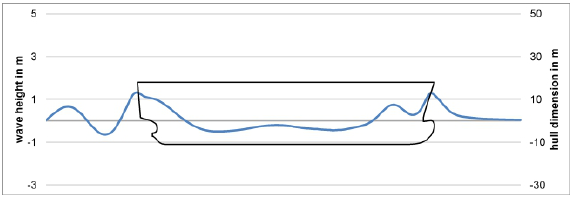
Figure 3. Typicalwavesystemofacontainership inopensea, speed 9 m/s. Data derived from CFD calculations by authors, re- scaled longitudinal